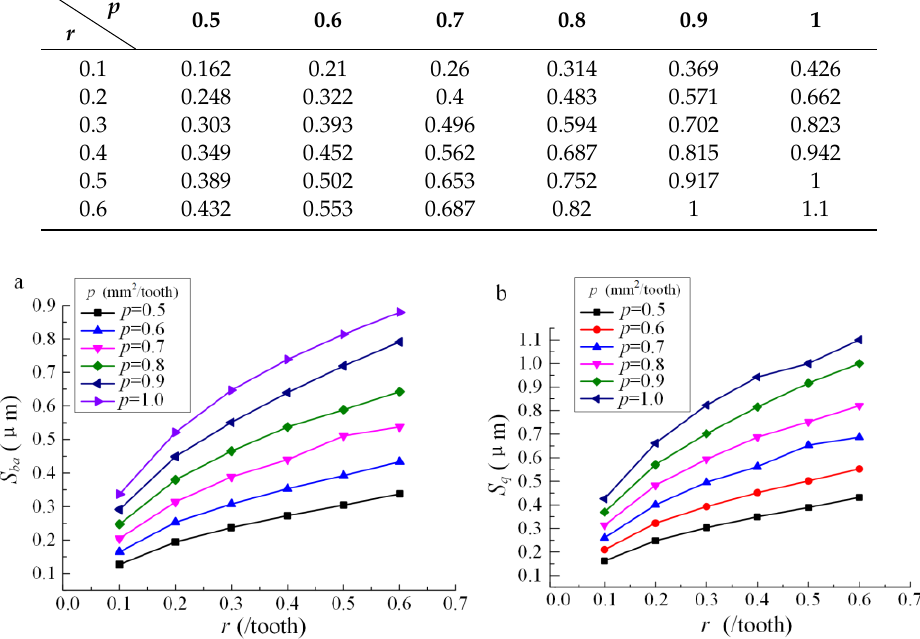
Figure 3. Profile of surface roughness under di ff erent p and r : ( a ) Profile of S ba ; ( b ) profile of S q .